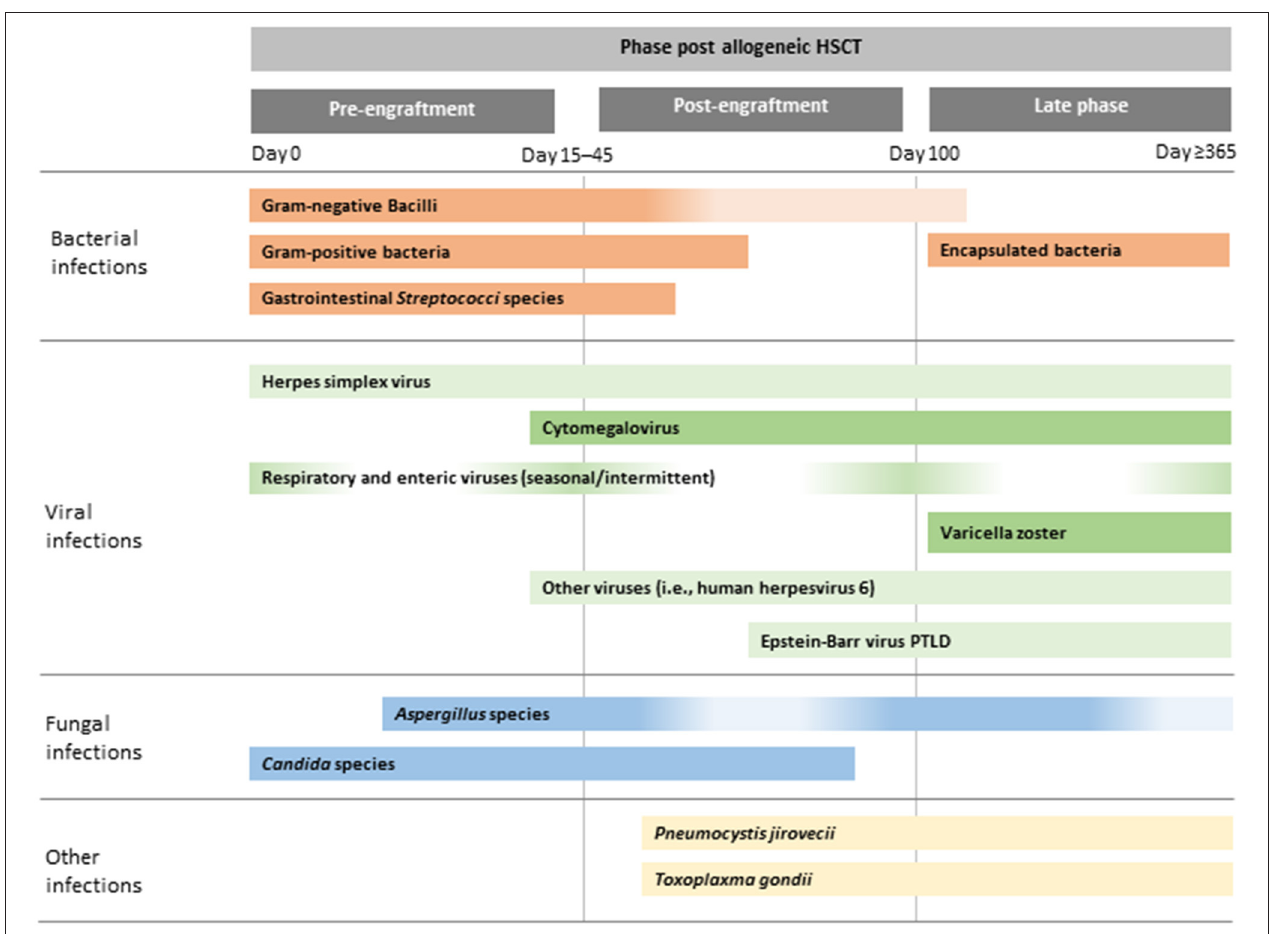
FIGURE 1 | Illustrative chronology of infectious complications after allogeneic HSCT. Greater depth of colour indicates more common infections. PTLD, post-transplant lymphoproliferative disease; HSCT, haematopoietic stem cell